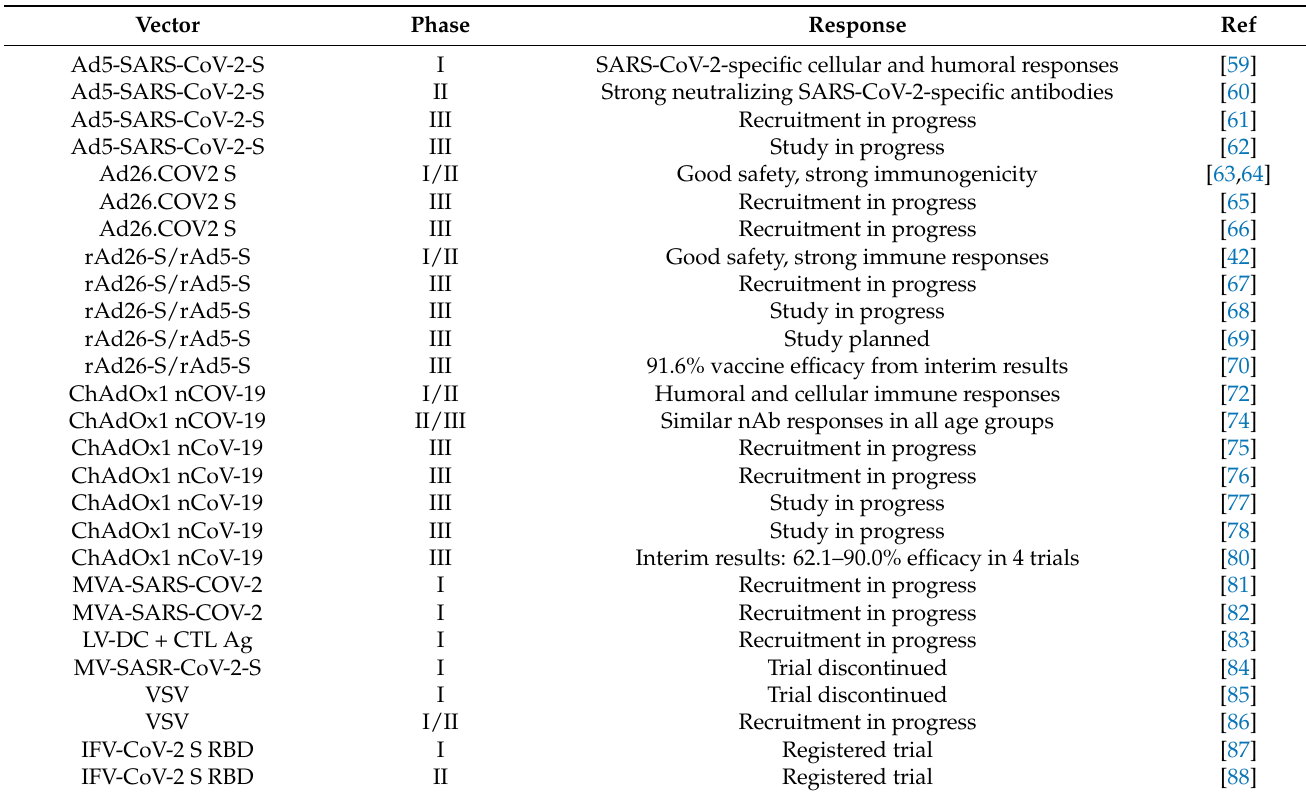
Table 2. Examples of clinical studies for viral vector-based SARS-CoV-2 vaccine